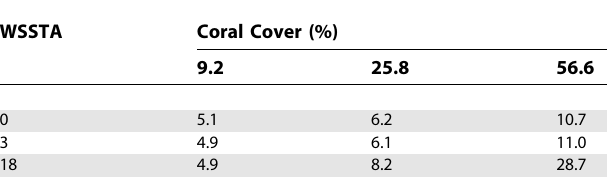
Table 3. Predicted Number of White Syndrome Cases WSSTA Coral Cover